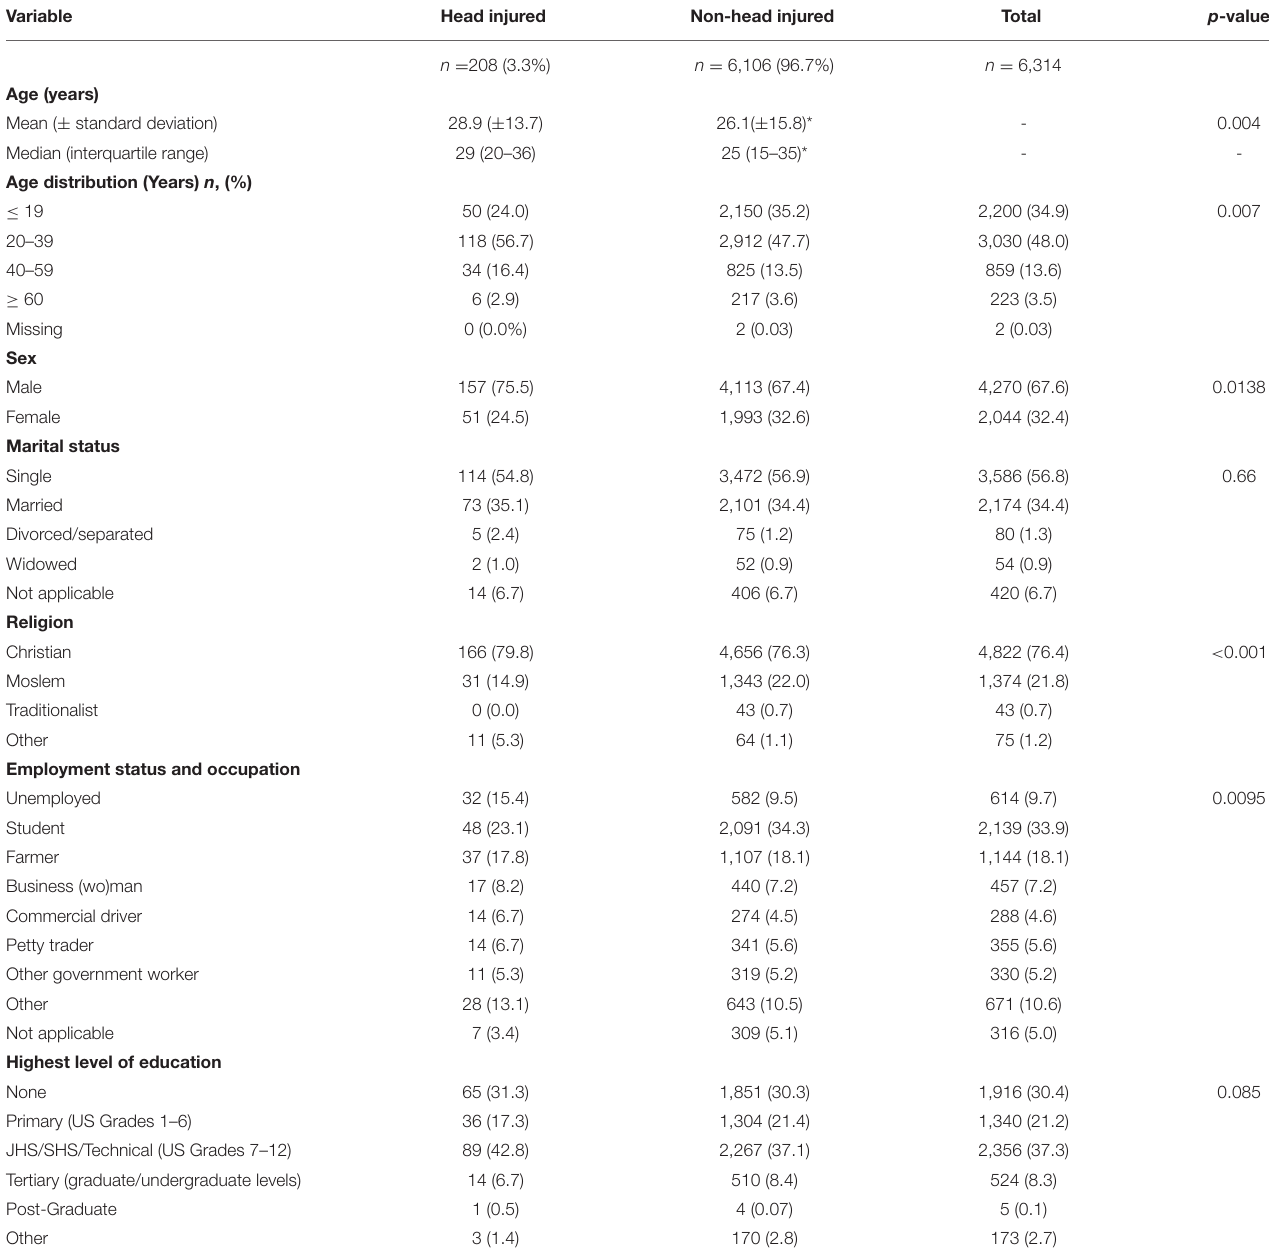
TABLE 1 | Demographic characteristics of head injury patients in the Kintampo Registry ( n = 6,314).